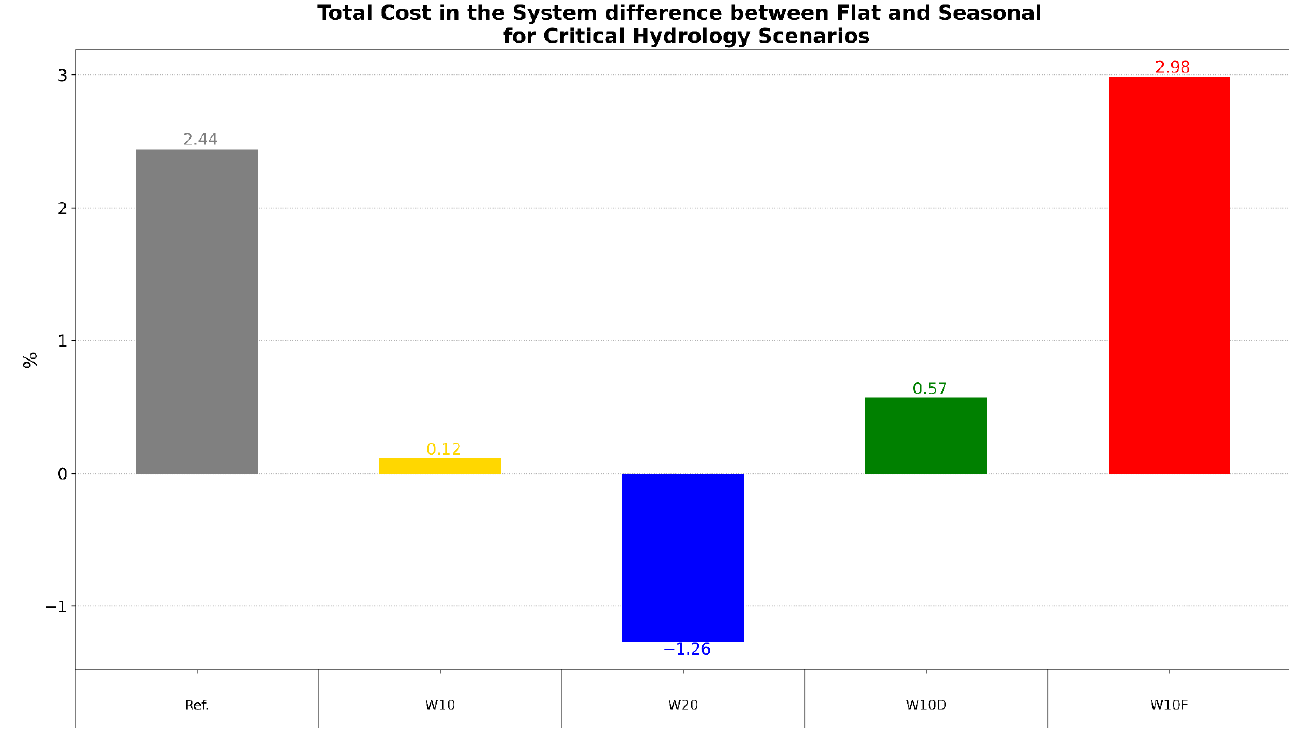
Figure 7. Percentage difference between flat and seasonal cases for total cost in the system for scenarios with critical hydrology.